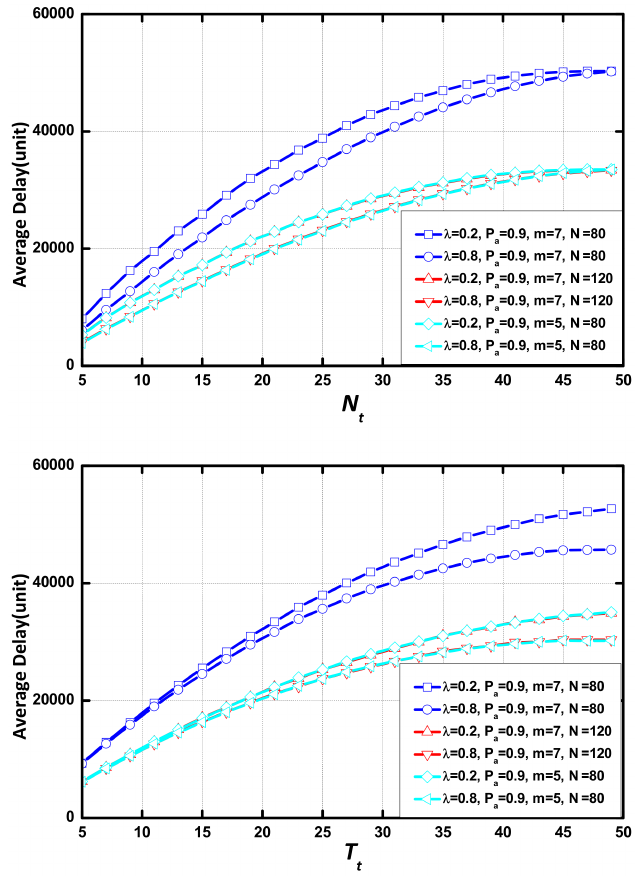
Figure 6. Average delay in various circumstance vs. N t or T t